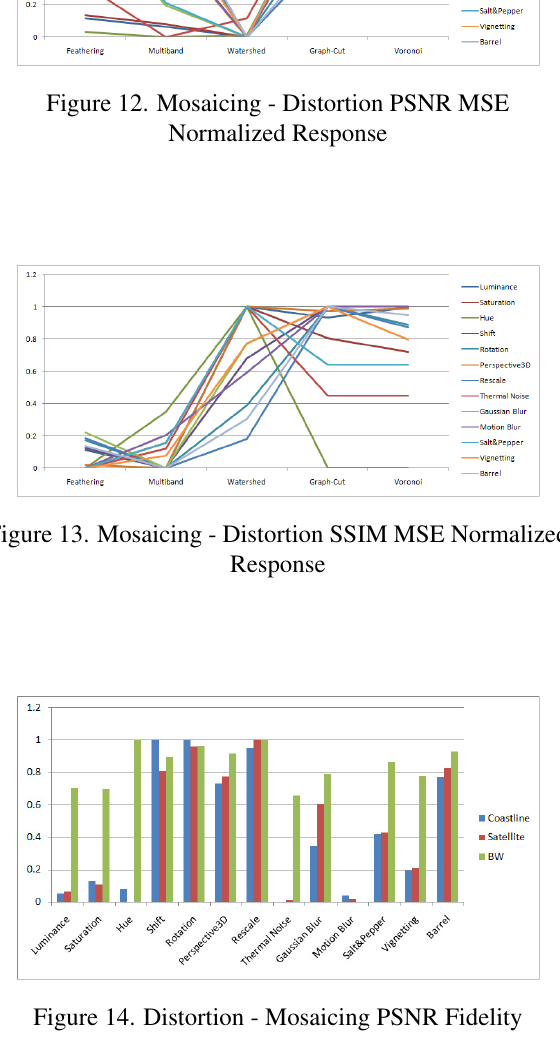
Figure 5. Distortion - Test Normalized PSNR MSE Response